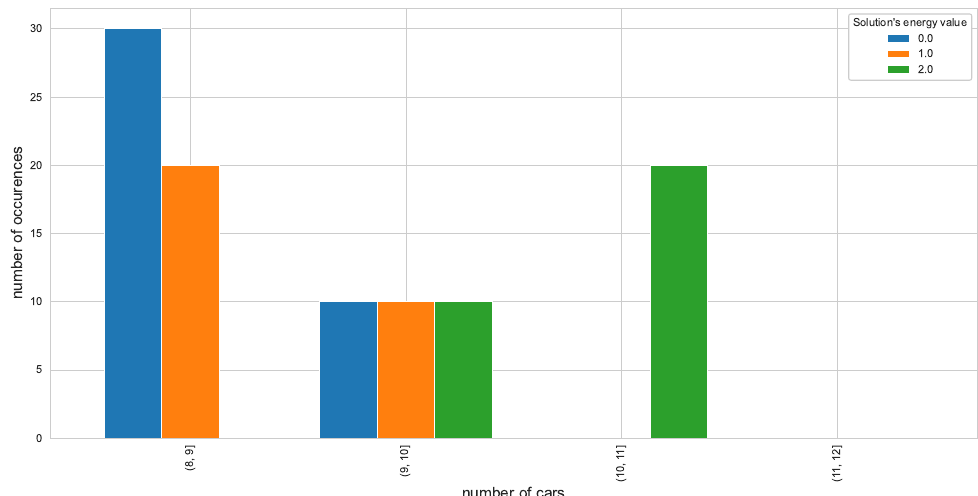
Figure 12. The quality of quantum-annealing based solutions to the conflict-free EMV charging problem with respect to the number of EMVs present on the A4 motorway. Different colors represent different numbers of unresolved collisions occurring in the solution.